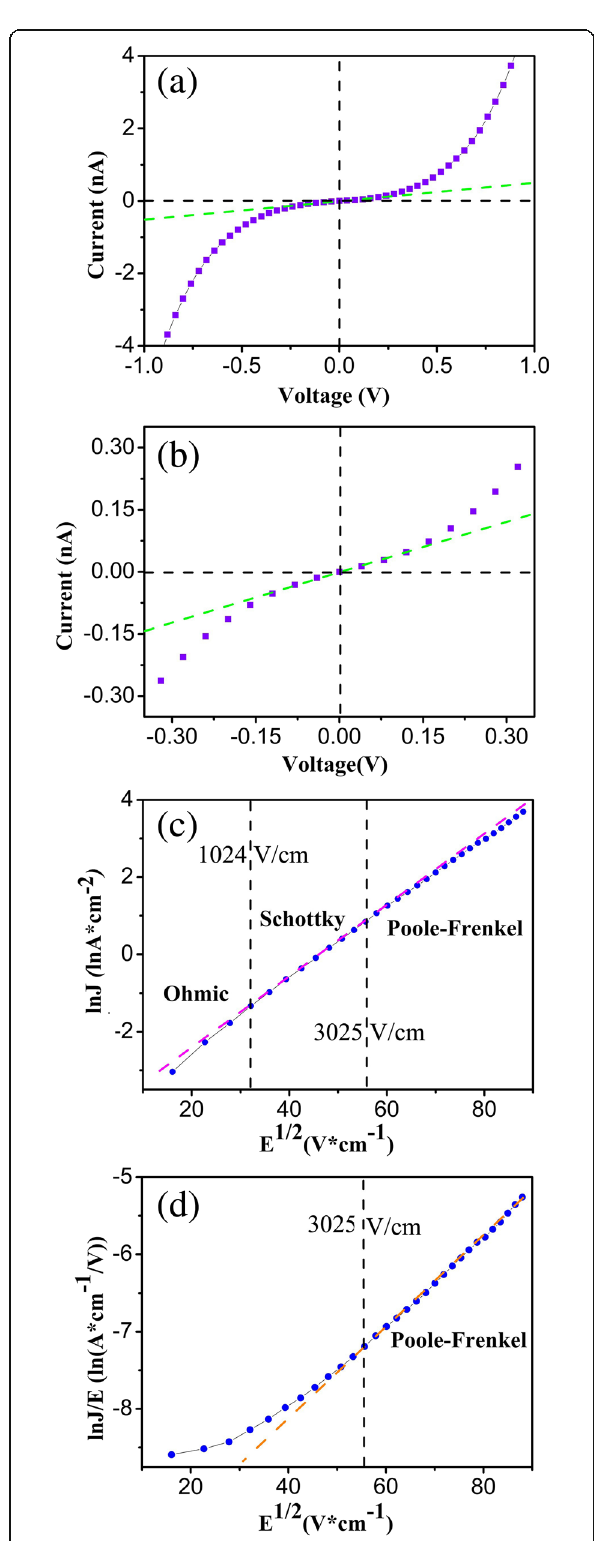
Fig. 4 a The I-V curve individual NiCo 2 O 4 nanowire device. b The enlarged image at low voltage values. c The plot of ln(J) vs E 1/2 according to the Eq. (1). d The plot of ln(J) vs E 1/2 according to the Eq.